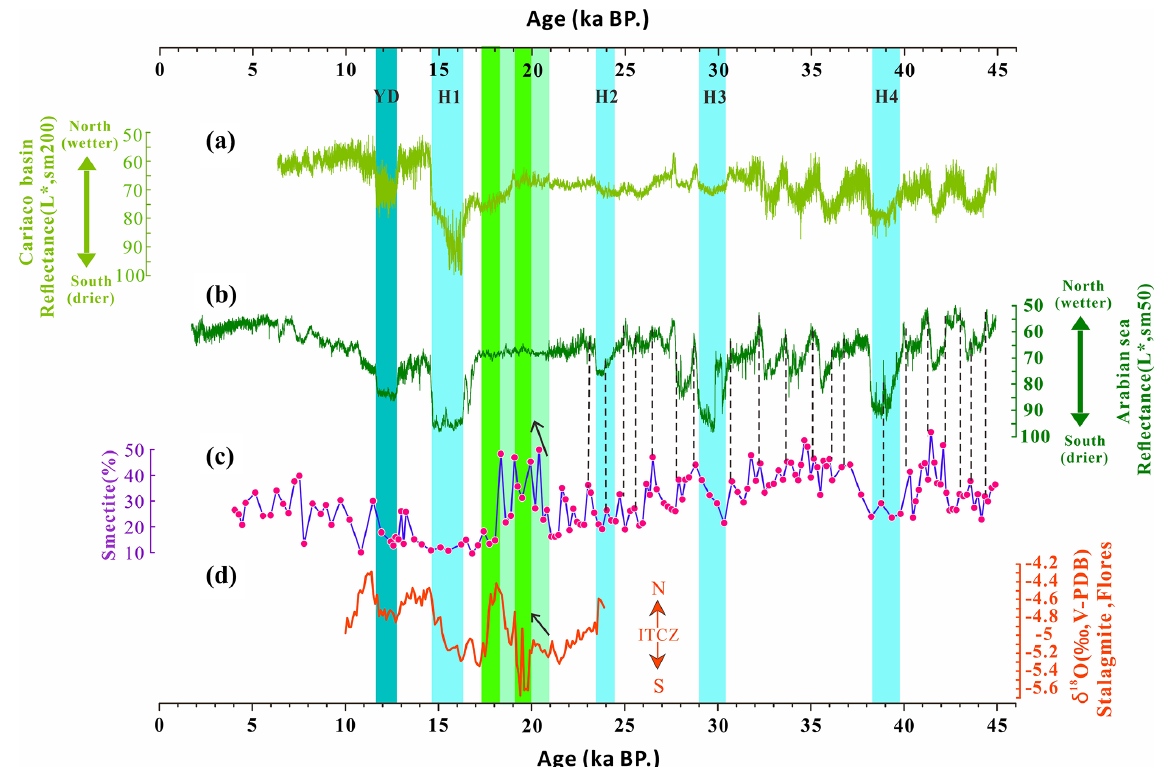
Figure 7. Comparison of smectite percentages with ITCZ north–south shift records. (a) L ∗ represents the ITCZ shift from the Cariaco Basin (Deplazes et al., 2013). (b) L ∗ represents the ITCZ shift from the Arabian Sea (Deplazes et al., 2013). (c) Smectite percentages in core 17I106. (d) Stalagmite δ 18 O record from Flores (Ayliffe et al., 2013). The gold dotted line denotes the connection between the northward movement of the ITCZ and the peak smectite percentage, and the series of color bars from 21 to 18ka represent the ITCZ shift periods recorded in (d) . The green bars represent the consistent periods shown in (c, d) in the late LGM, and the black arrows in (c, d) indicate great differences between the smectite percentages and ITCZ record in the